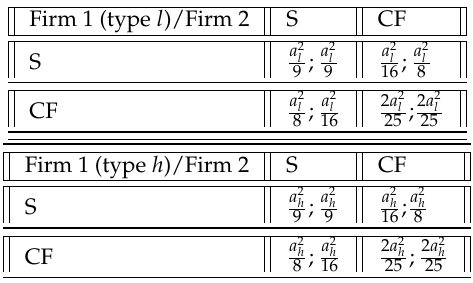
Figure 2. Matrix of payoffs for different types of